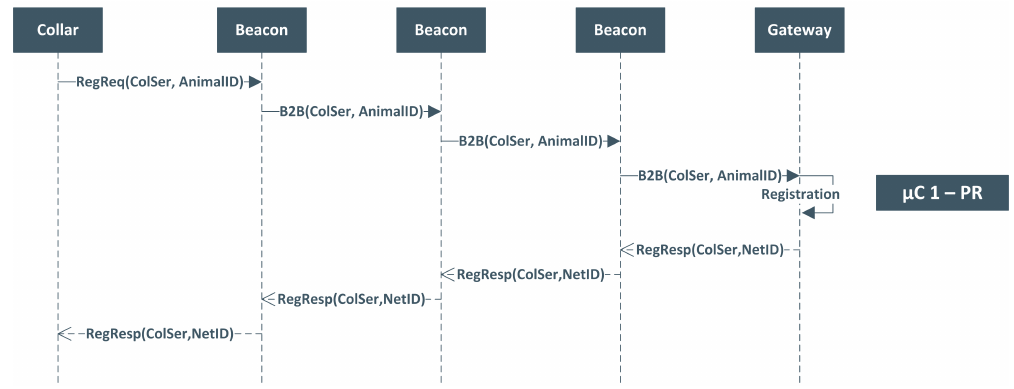
Figure 7. Collar Registration Message Sequence